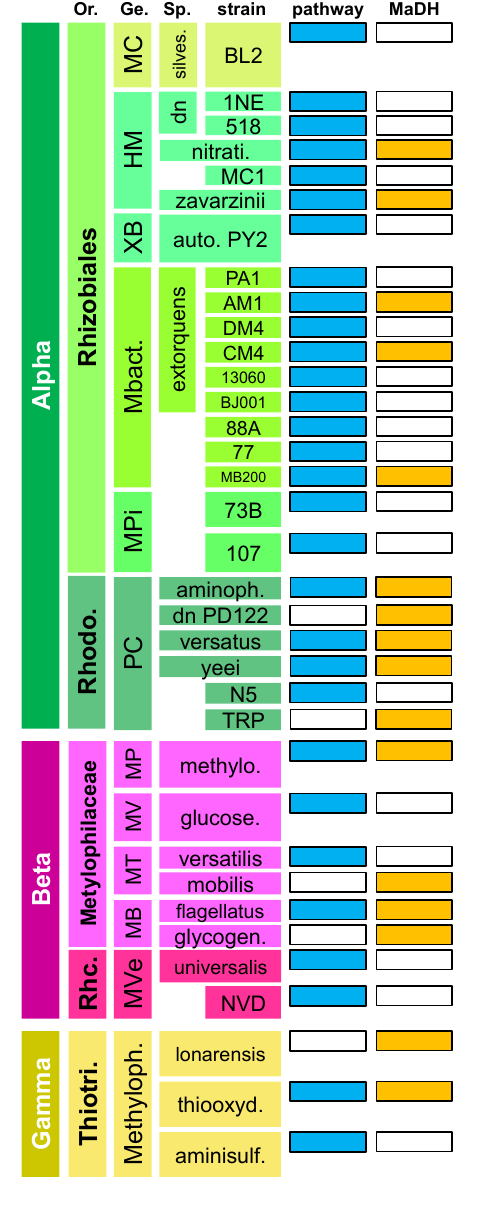
Figure 2. Distribution of genes of the N- methylglutamate pathway (in blue) and the mau gene cluster encoding methylamine dehydrogenase (in orange) in the genome of sequenced methylotrophs of the Alpha—(green), Beta—(pink), and Gamma—(yellow) Proteobacteria that contain at least one pathway for methylamine oxidation. Or.: Order; Ge.: Genus;